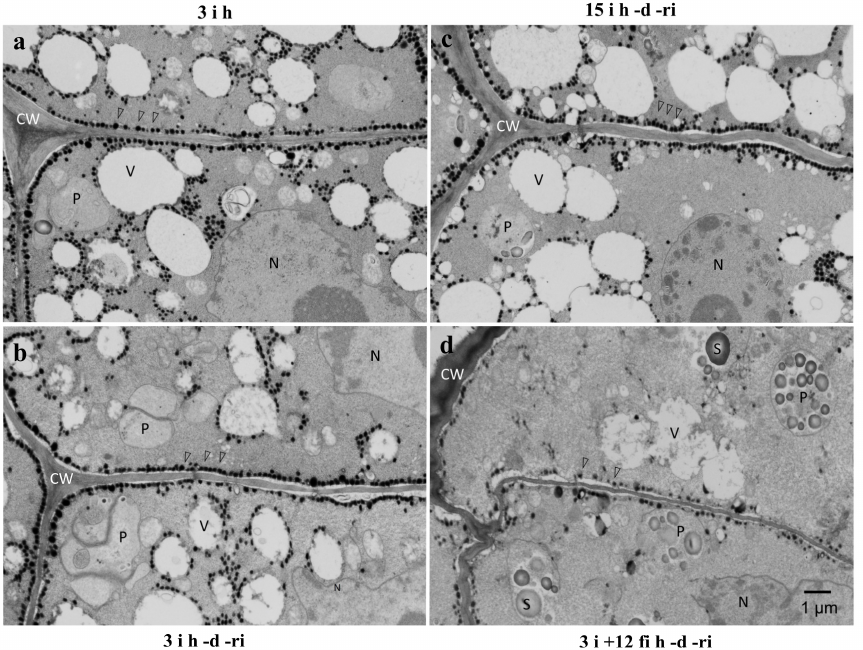
Figure 7. TEM observation of radicle cells in differently treated embryonic axes. Numerous lipid droplets (open arrowheads) were observed lining the plasma membrane of radicle cells of